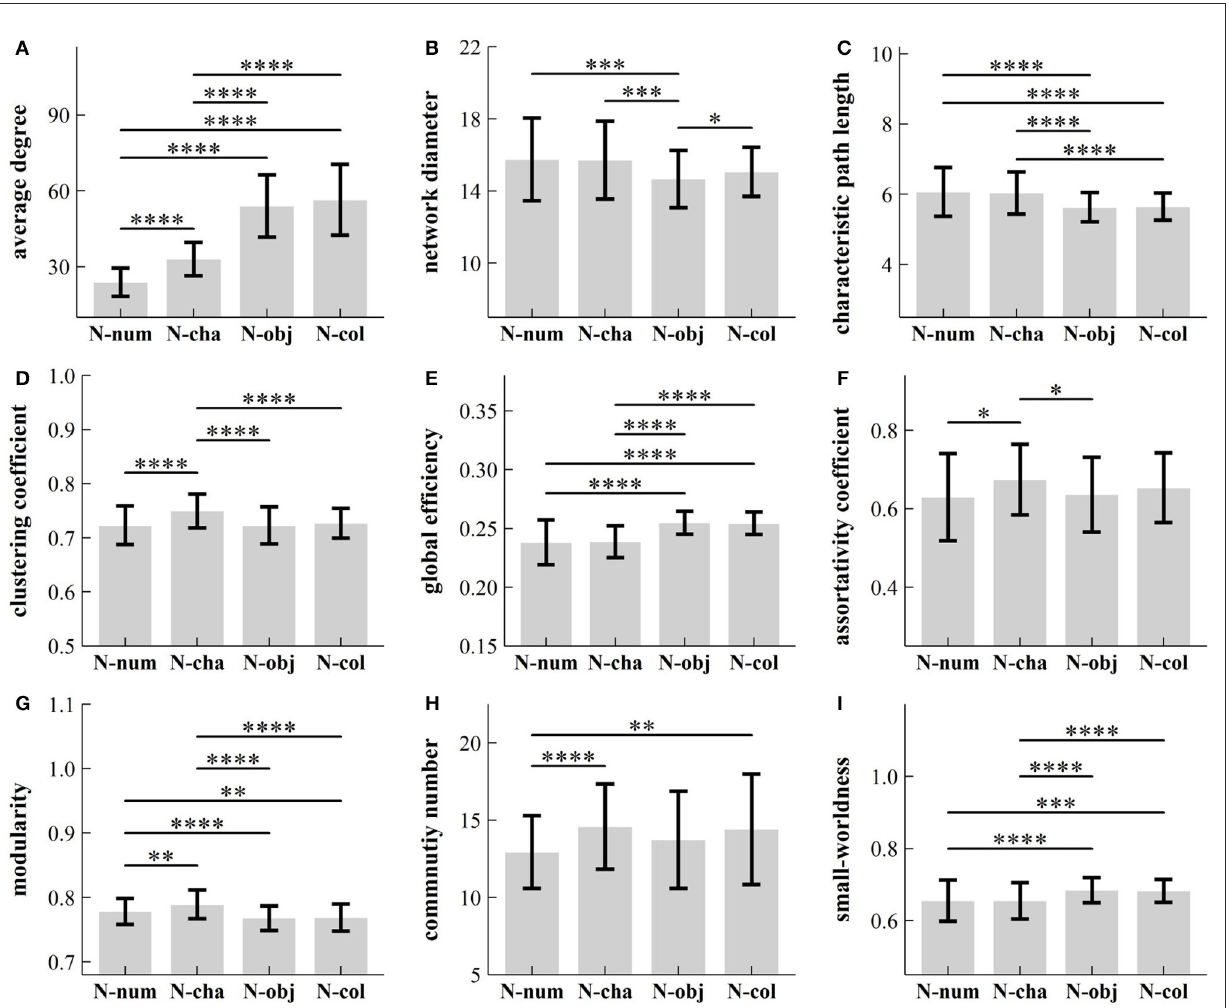
FIGURE3 Influence of task types on different topological parameters: (A) average degree; (B) network diameter; (C) characteristic path length; (D) clustering coefficient; (E) global efficiency; (F) assortativity coefficient; (G) modularity; (H) community number; and (I) small-worldness. * p < 0.05; ** p < 0.01; *** p < 0.001; **** p < 0.0001. RAN, rapid automatized naming; N-num, naming of numbers; N-cha, naming of Chinese characters; N-col, naming of colors; N-obj, naming of